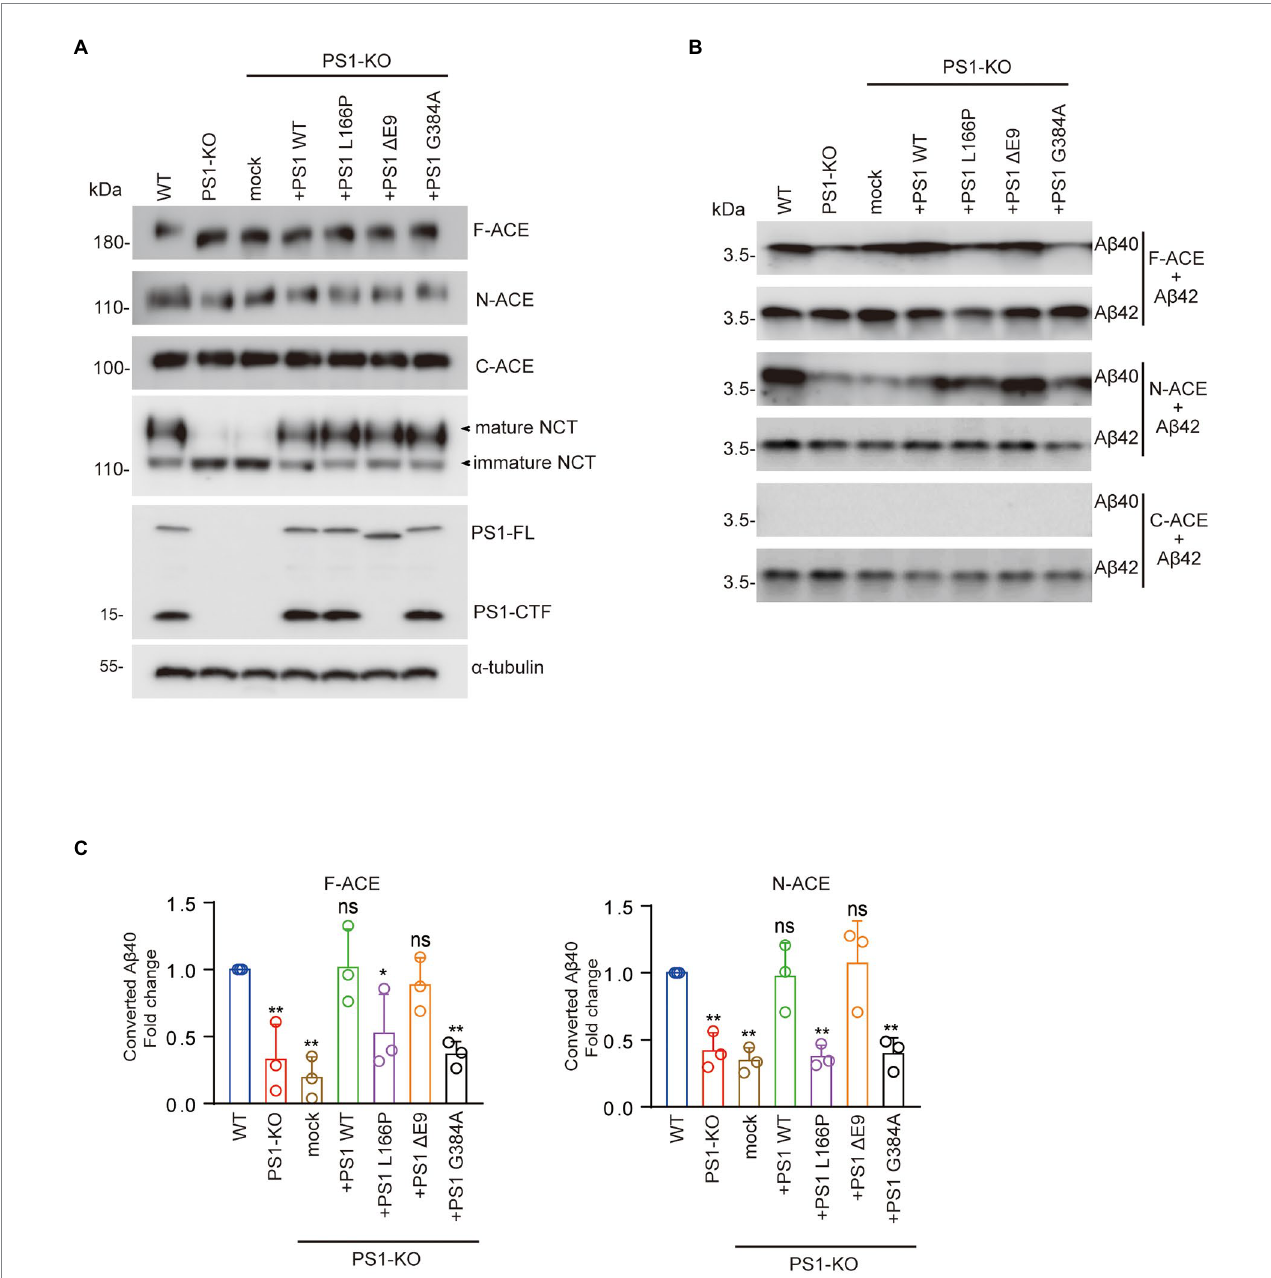
FIGURE 3 FAD-linked PS1L166P and PS1G384A mutations did not restore A β 42-to-A β 40–converting activity of ACE. (A) Fibroblasts were transfected with empty vector or PS1WT or PS1 mutant plasmids. Recombinant ACE proteins, NCT, PS1, and α -tubulin were detected by Western blotting. (B) F-, N-, and C-ACE purified from WT and PS1-KO fibroblasts or PS1-KO fibroblasts transfected with PS1WT or PS1 mutant were mixed with synthetic A β 42 and incubated at 37 ° C for 2 h. Western blots of the mixtures were probed with anti-A β 40 and anti-A β 42 antibodies. (C) Quantification of A β 40 converted from A β 42. PS1L166P and PS1G384A did not restore the A β 42-to-A β 40–converting activity of F-ACE and N-ACE proteins, whereas PS WT and PS1 Δ E9 restored this activity. Values represent the mean ± SD; n = 3; *, p < 0.05, **, p < 0.01. NS, not significant, Holm-Sidak’s multiple comparisons